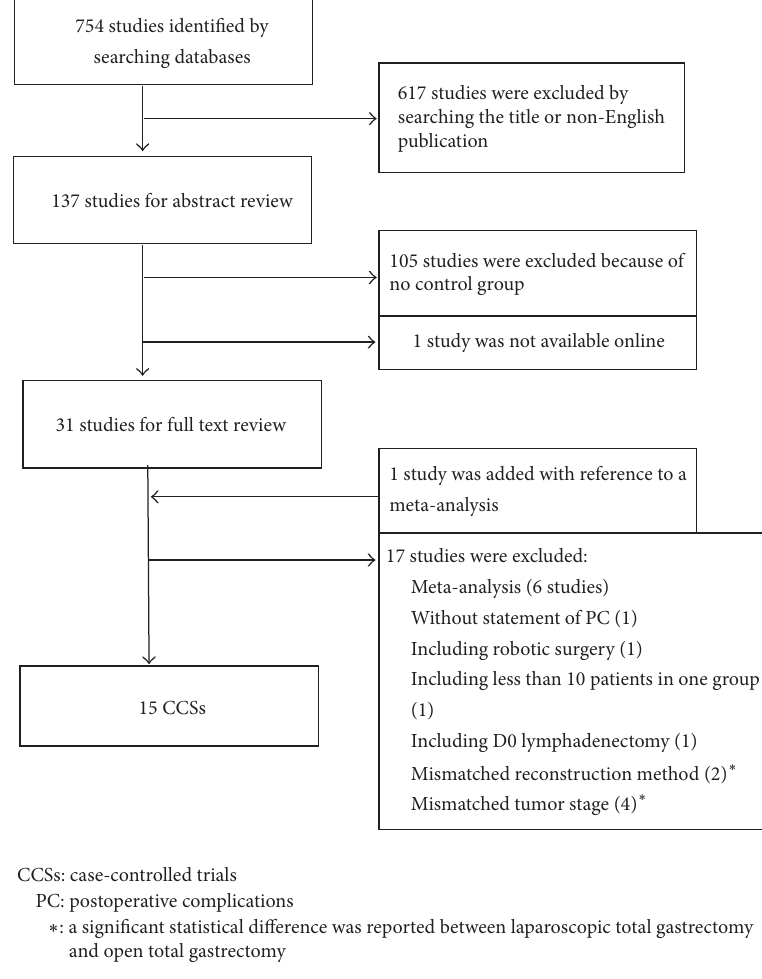
Figure 1: Flowchart of study